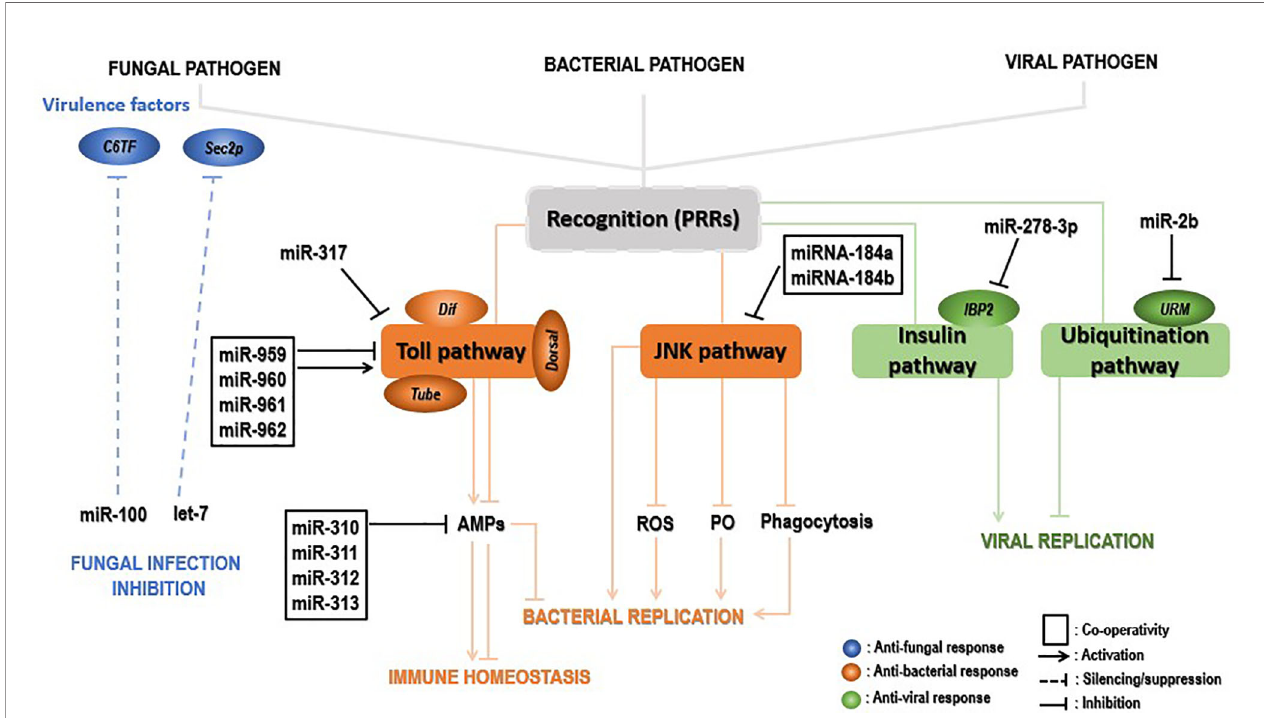
FIGURE 4 | Insect immune defense modulation by miRNAs upon pathogenic invaders. Upon fungal invasion, insect miRNAs can silence fungal virulence genes, such as C6TF and Sec2p , and inhibits its replication (blue). Upon bacterial invasion, insect miRNAs individually or synergistically regulate the Toll pathway key components ( Tube , Dorsal , Dif , etc.) positively, leading to activation of AMP gene effectors and inhibition of bacterial replication. Those elements can negatively modulate the same signaling at the late stage of the infection, decreasing the AMP gene expression for insect immune homeostasis. On the other hand, insect miRNAs can promote bacterial replication by inhibiting the JNK signaling pathway and indirectly those under its control (ROS, PO, phagocytosis) (in the pea aphid Acyrthosiphon pisum , for instance) (brown). Lastly, IBP2 is signi fi cantly upregulated upon viral invasion of insects. The latter ’ s expression is drastically repressed by insect miRNAs, leading to viral replication. In contrast, insect miRNAs inhibit viral replication by downregulating components ( URM ) of the ubiquitinylation process